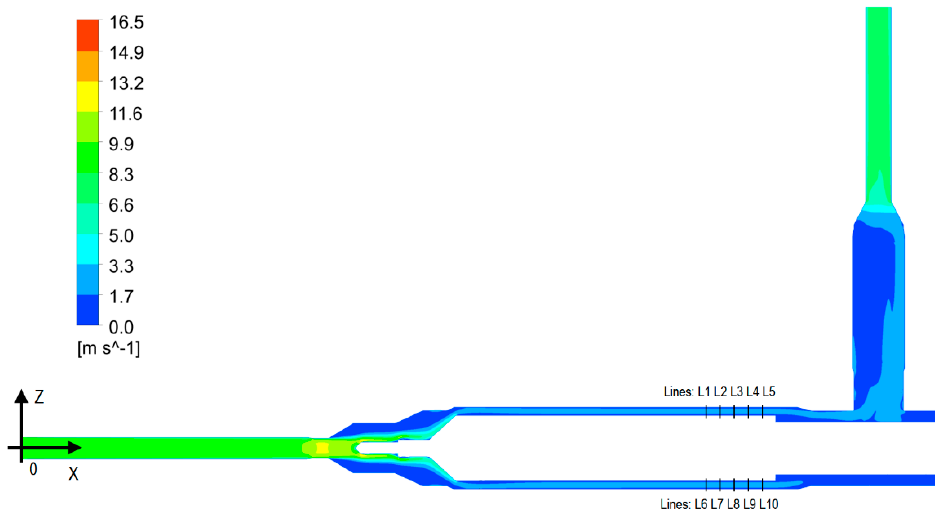
Figure 10. Average heat flux of Tube-3 towards coolant at the heated zone.